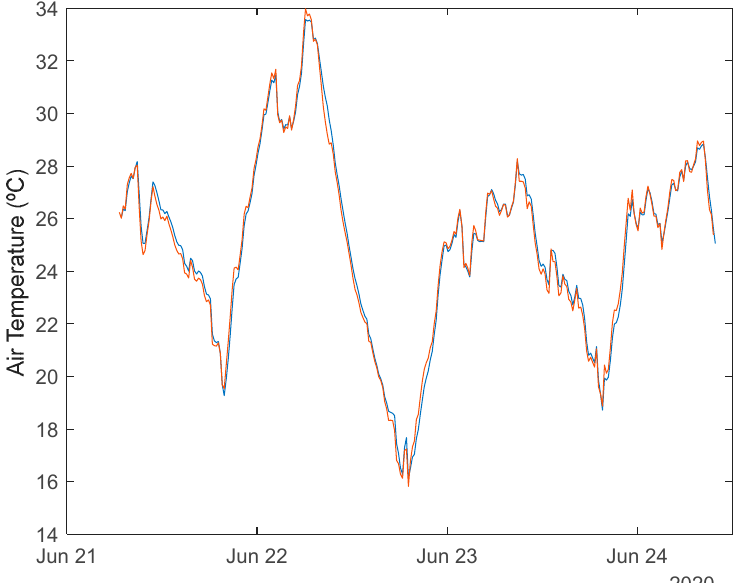
Figure 10. Measured (blue) and one-step-ahead forecast (red) air temperature for four selected days.